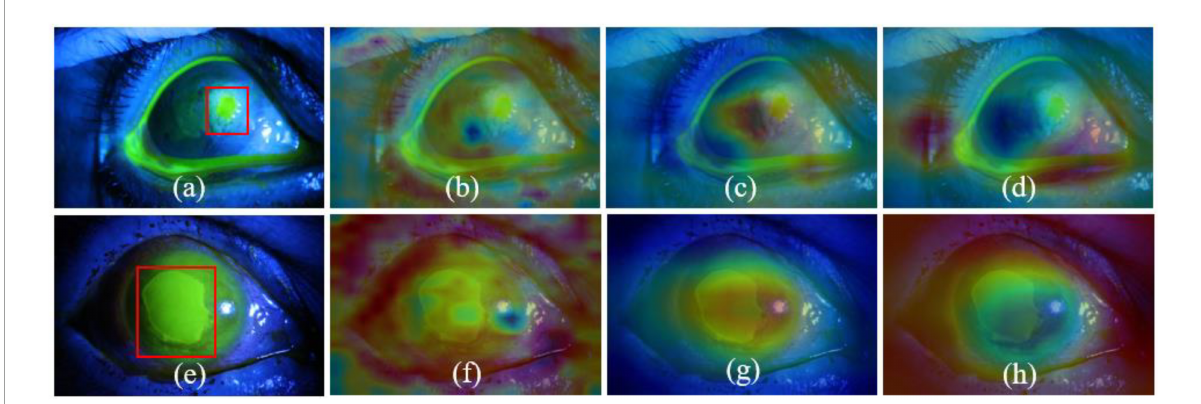
FIGURE3 Visualization results of CAM. Panels (a,e) are the original images, where the ulcer-related pathologies are in red boxes. Panels (b,c,f,g) are the heat maps of the second and fourth stages of the proposed MIF-Net, while the panels (d,h) is the heat maps of the fourth stage of Backbone.